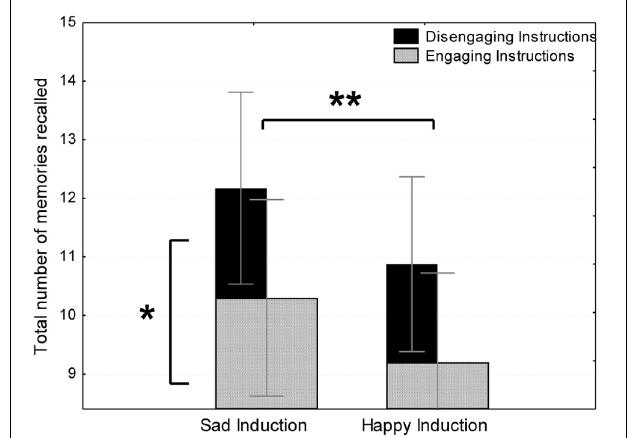
FIGURE 2 | Total number of memories recalled in emotionally engaging instruction and mood induction conditions in Study 1